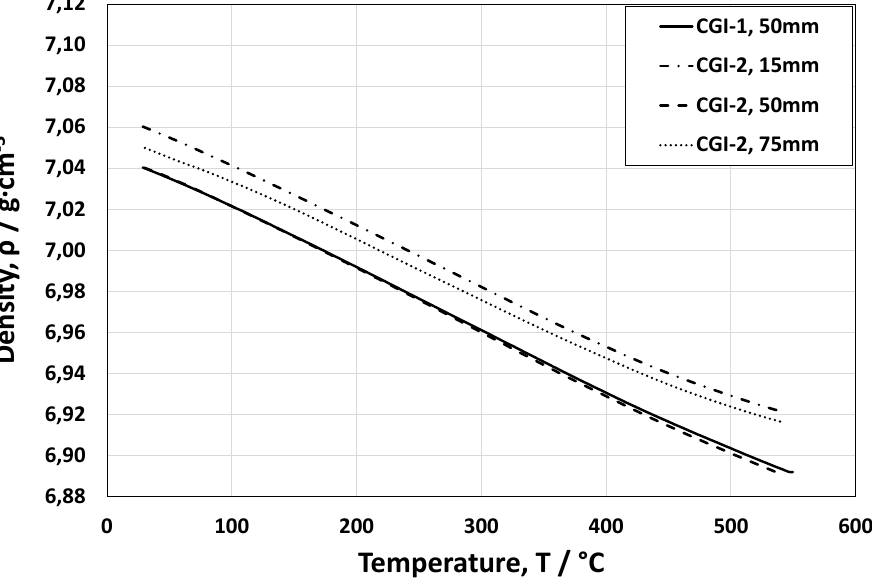
Figure 13. Density of the CGI as a function of temperature (during heating